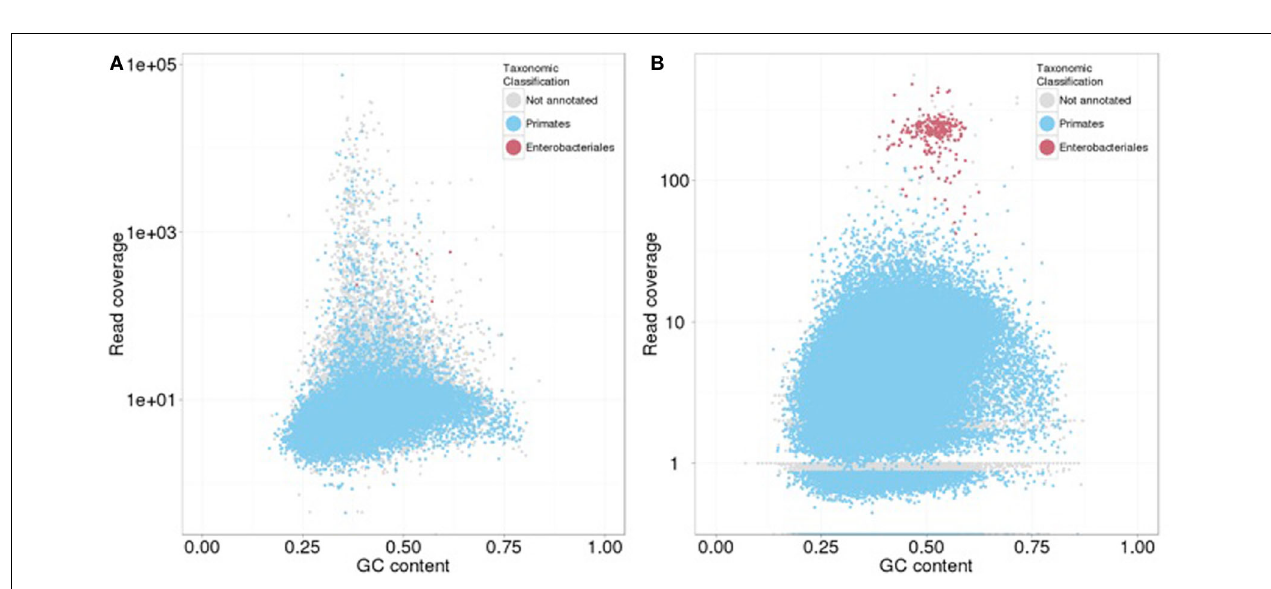
FIGURE 8 | Taxon-annotated GC-coverage (TAGC) plots for the mock-contaminated E. coli -human library. (A) TAGC-plot generated after alignment to the CLC assembly; (B) TAGC-plot generated after alignment to the SOAPdenovo2 assembly. Individual contigs are plotted based on GC (X